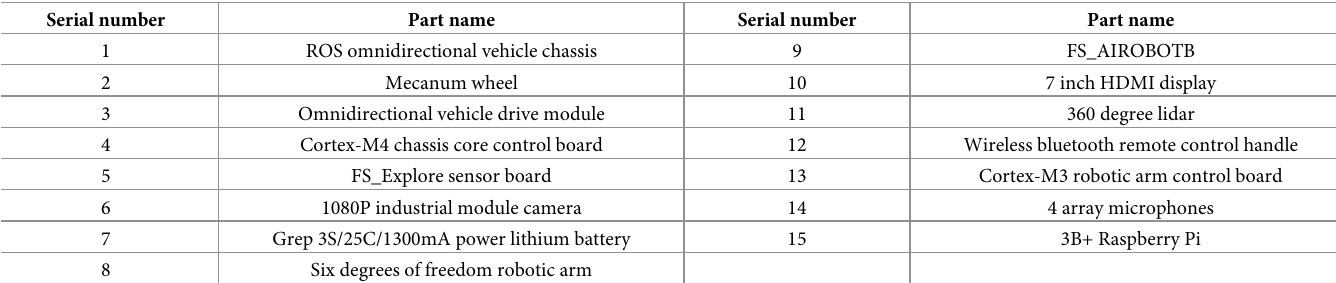
Table 10. FS-AIROBOTB component serial number comparison table.